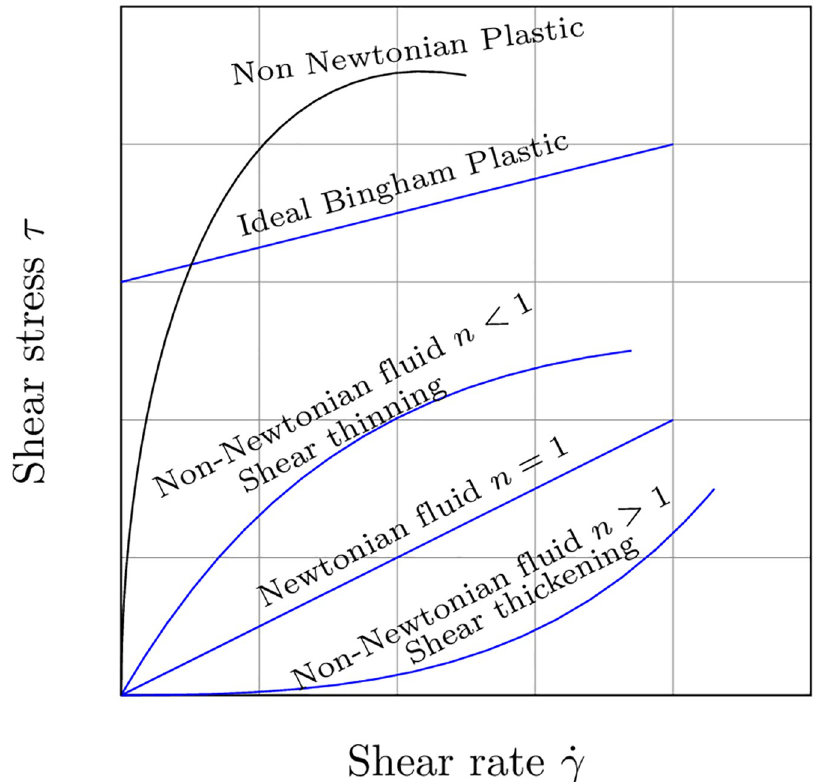
Fig 2. Standard classification of the fluid families considered herein. In the case of Newtonian fluids, their properties are constant over time and show a linear response. Their flow index n is then set to 1, and their yield stress to τ 0 = 0. In contrast, shear thinning fluids start flowing when the stimulus is greater than the yield stress τ 0 > 0. For these fluids, n > 1. In this work, fluids whose behavior can be assimilated to shear thinning have been considered. Fluids that incorporate some kind of plastic behavior need for a special treatment and have not been considered